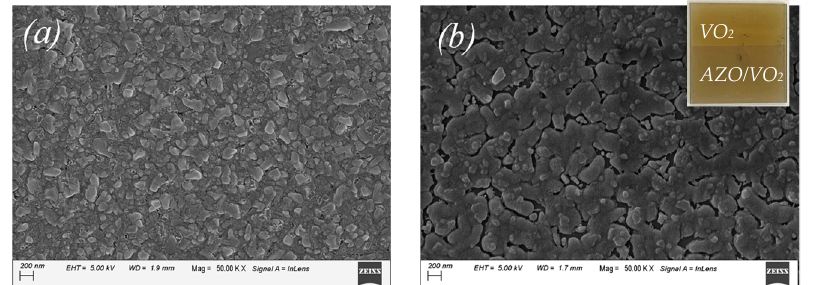
Figure 4. SEM images of ( a ) VO 2 thin film sample and ( b ) AZO/VO 2 thin film sample measured at room temperature. Inset of figure ( b ) shows the photo of sample used for SEM measurement.